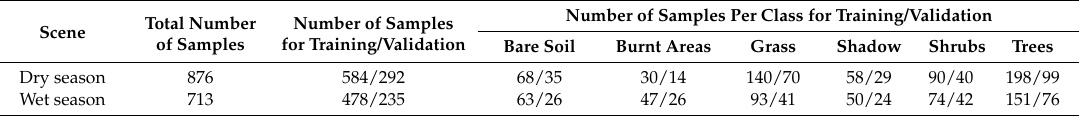
Table 3. Number of training/validation samples taken for the different classes and